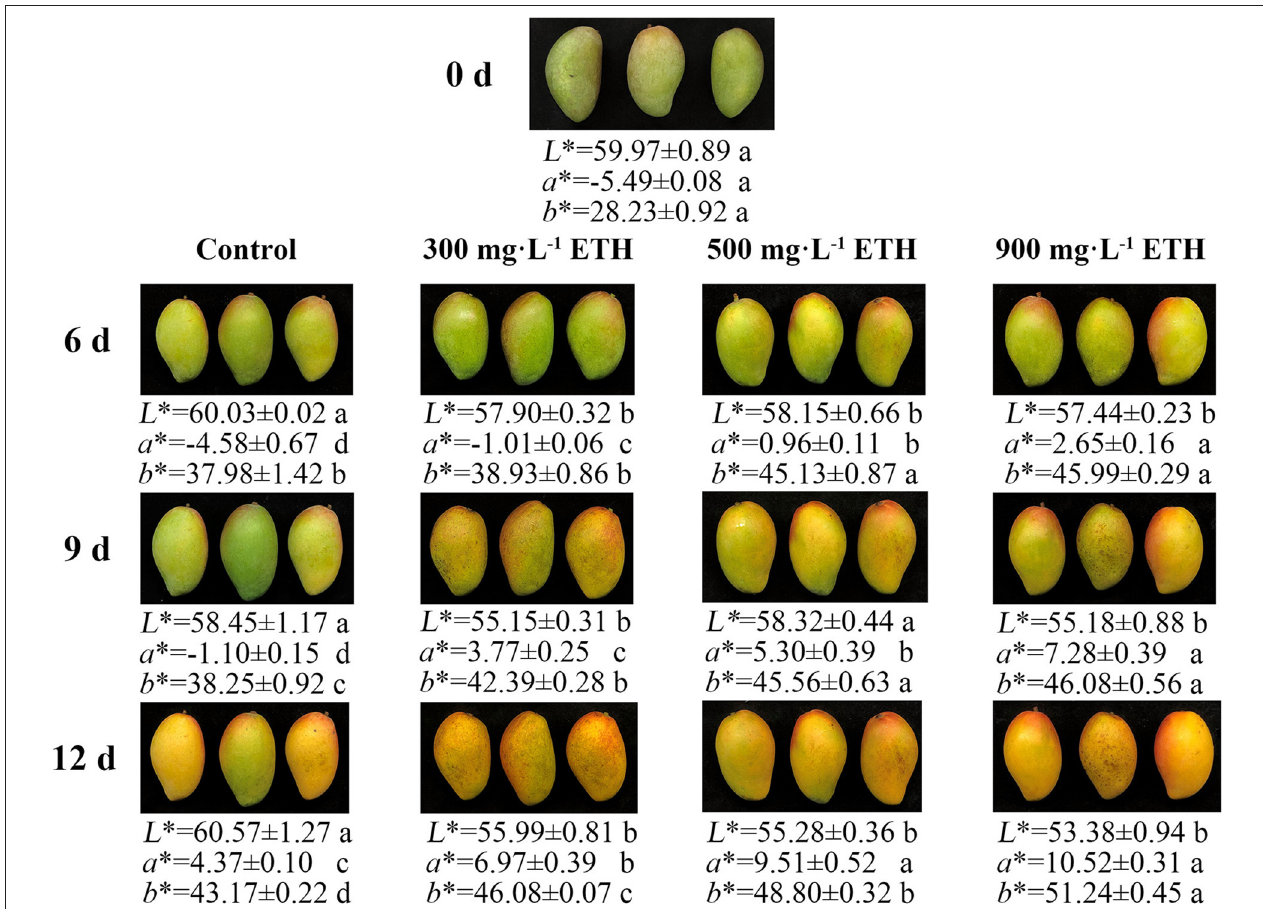
FIGURE 1 | Effects of ETH treatment on peel color transformation in postharvest mango fruit. Photos were taken on 0, 6, 9, and 12 days after treatment.